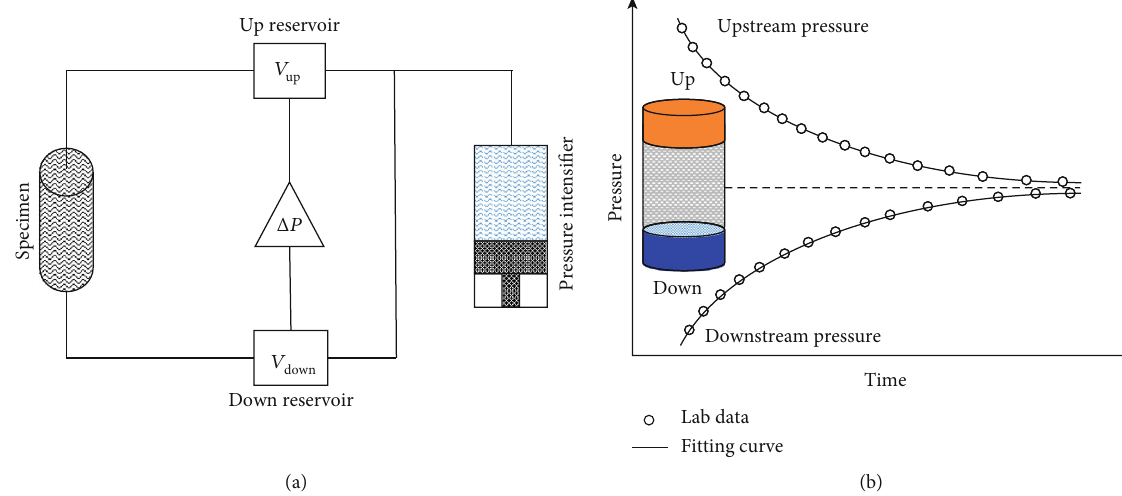
Figure 1: Simpli fi ed schematic of the transient pulse method: (a) testing system and (b) measuring pressure decay over time.